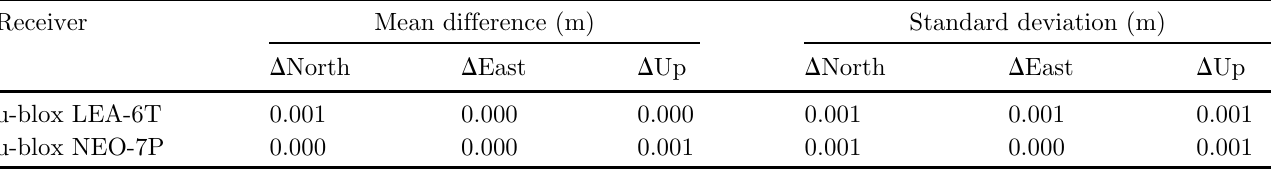
Table 4. Statistics for the zero baseline